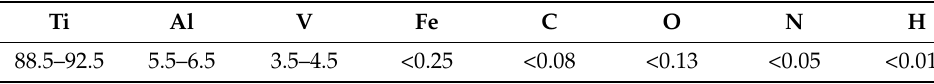
Table 1. Ti6Al4V alloy chemical composition (percent of weight).